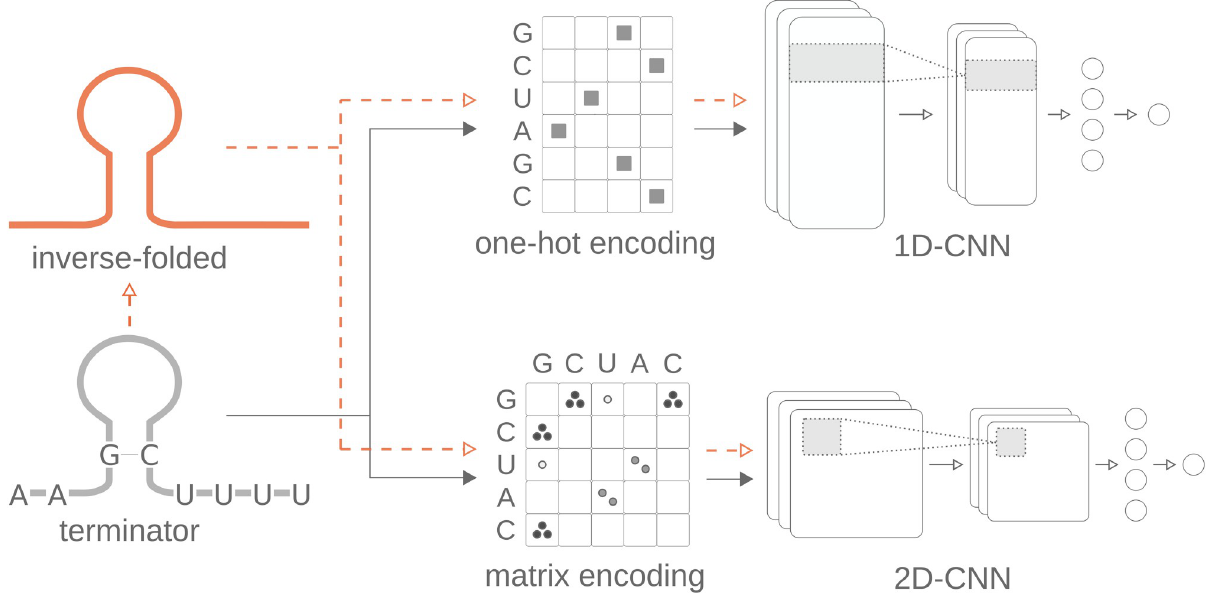
Fig 1. Model architectures and training strategy. The model input is formed by terminator sequences. In the pre-trained model, the models are first trained with inverse-folding based data before training with terminator sequences. These pre-training data feature the structure of terminators, but not their specific sequence properties. The input data are either one-hot encoded and fed into a 1D-CNN, or matrix encoded and then passed into a 2D-CNN. Both CNN architectures are followed by a fully connected layer and a single output neuron.